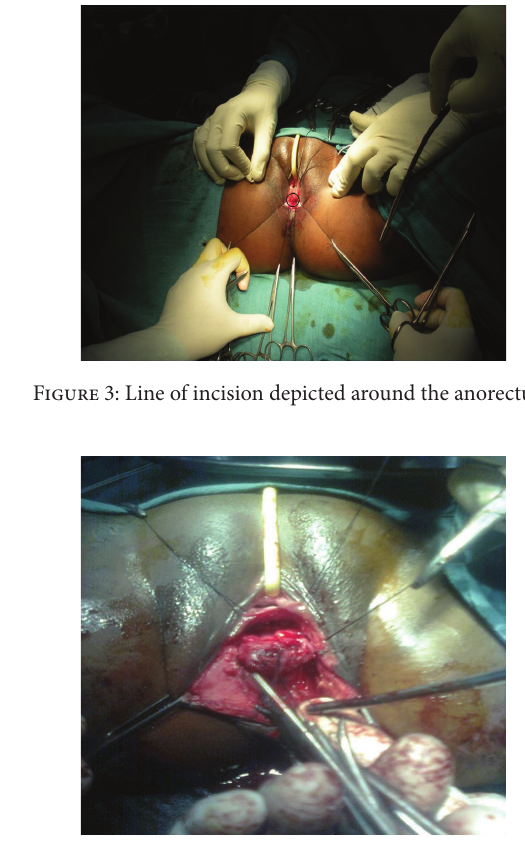
Figure 4: Circumferential mobilization of anorectum.